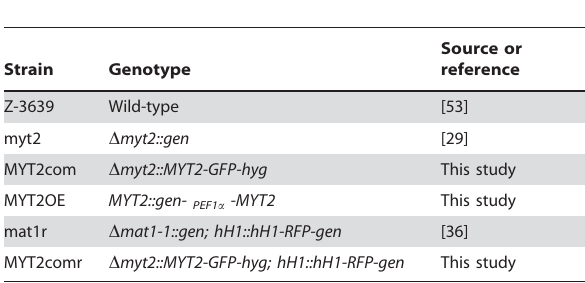
Table 1. G. zeae strains used in this